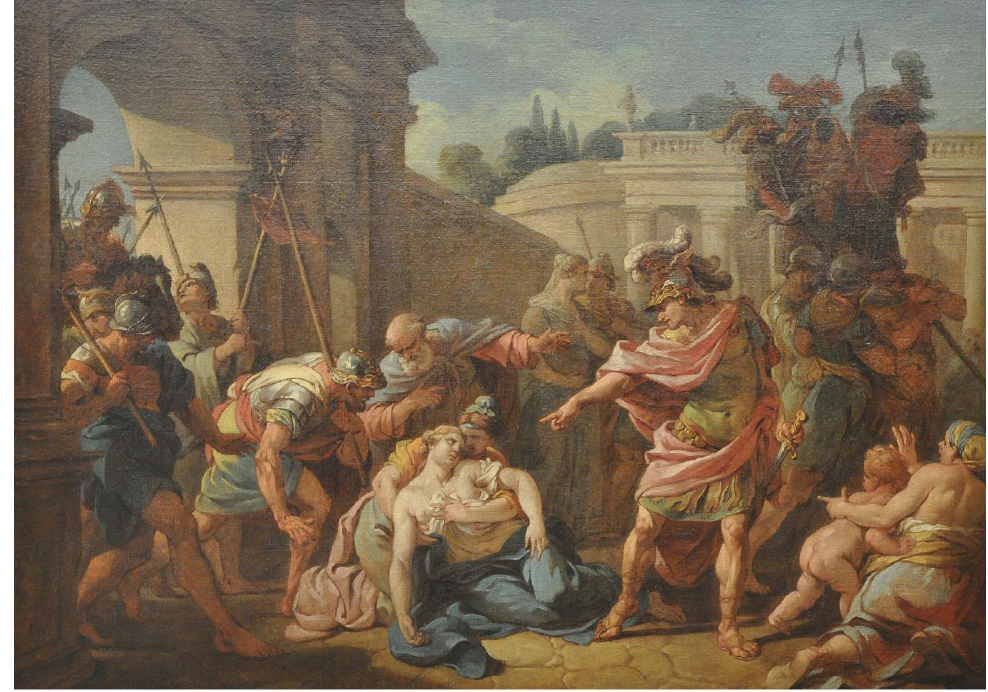
Figure 2. Louis Jean François Lagrenée, Horatius Killing His Sister (1753). Image source: Wikimedia Commons (https: // commons.wikimedia.org / wiki / File:Lagrenée_Horace_venant_de_frapper_sa_soeur. jpg). Public